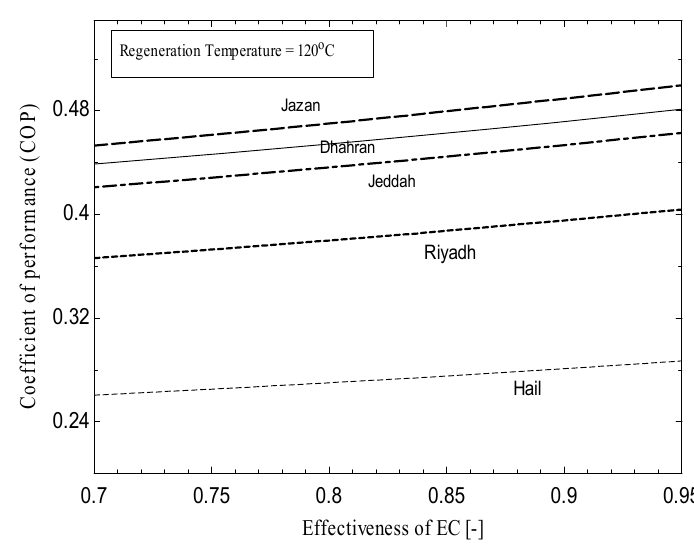
Figure 6. Variation of coefficient of performance with effectiveness of evaporative cooler.